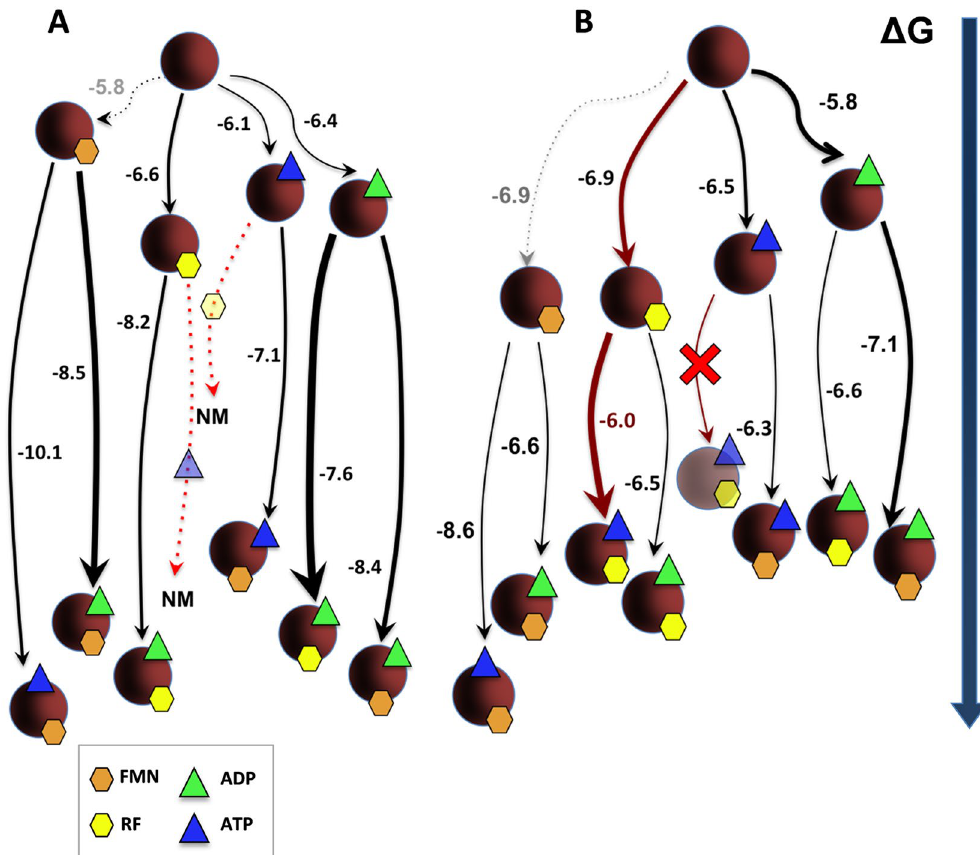
Figure 4. Gibbs free energy flow in the interaction between the RFK module and its ligands. Diagrams of the thermodynamics of interaction between the RFK module and different combinations of its ligands as obtained through ITC at 25 °C ( A ) in 20 mM PIPES and 0.8 mM MgCl 2 , pH 7.0 and ( B ) in 20 mM PIPES, pH 7.0. The RFK module is represented as maroon spheres, RF and FMN as yellow and orange hexagons, respectively, and ATP and ADP as blue and green triangles, respectively. Symbols for protein and ligands are shown with some level of transparency for those processes where calorimetric methods did not provide evidences of interaction. Numbers indicate the Δ G value for each titration. The thickness of arrows is proportional to the fraction of protein that is able to bind the ligand in each case, and the length of the lines is proportional to the Δ G value that is associated with each process. Dashed lines indicate processes that are not observed directly by ITC, but whose values were indirectly estimated using Eqn. 7 once the cooperativity coefficients were known. Red lines indicate the path leading to the simultaneous binding of both substrates required for RFK activity in the absence of the cation. NM accounts for processes with RF and ATP:Mg 2 + , where the heat exchanged in the catalytic reaction masks the interaction